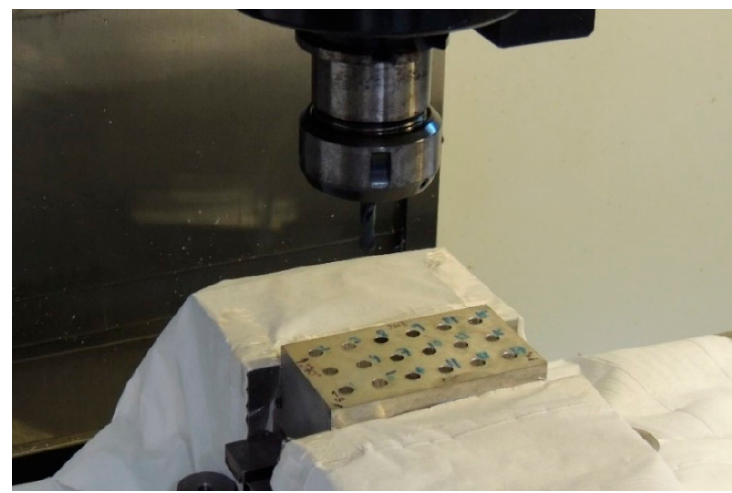
Figure 2. Detail of the method for collecting chips.